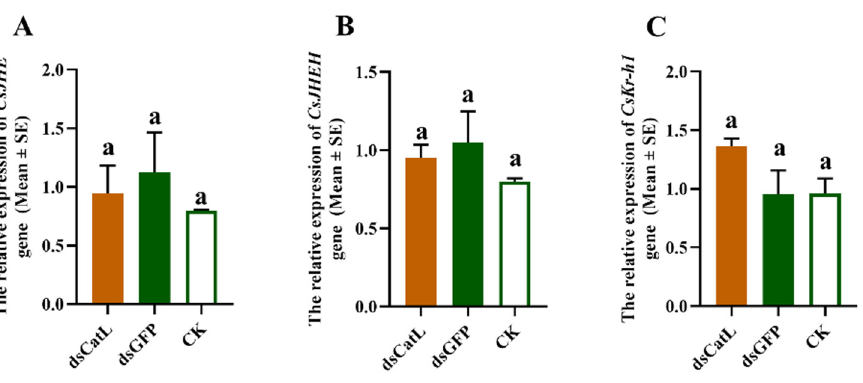
Figure 5. Relative expressions of CsJHE ( A ), CsJHEH ( B ), and CsKr-h1 ( C ) were determined on the 7th day after injection of dsRNA. Data are presented as mean ± SE (one-way ANOVA). The letters “a” indicates no significant difference ( p > 0.05).